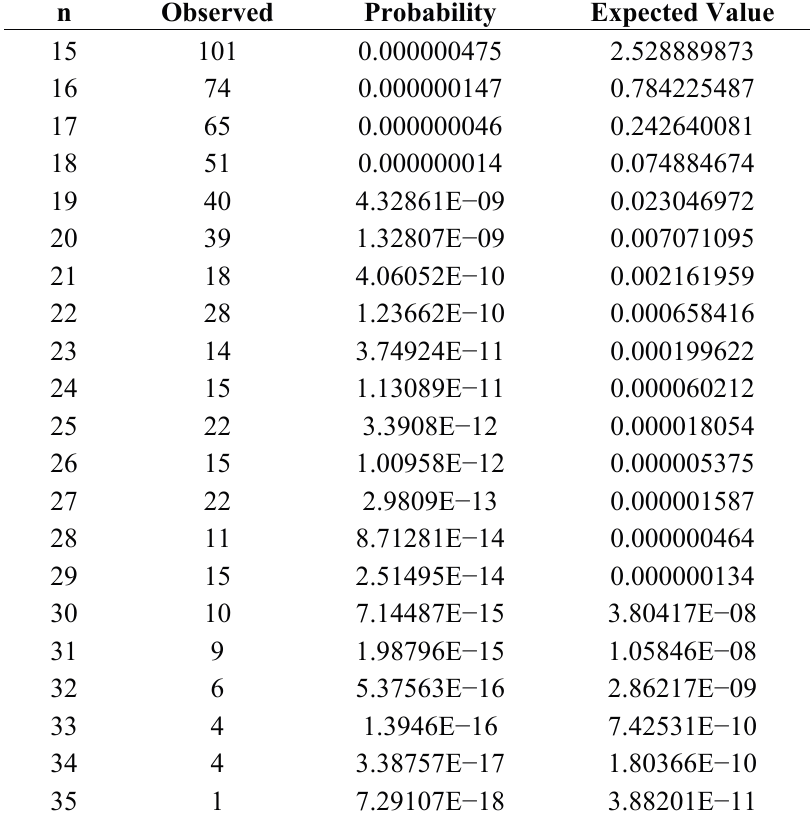
Figure 1. Some fragments from the S. aureus strain MW2 problem. Table 1. Observed frequency on n bases A vs. expected value for p = 0.3249 and 5,324,340